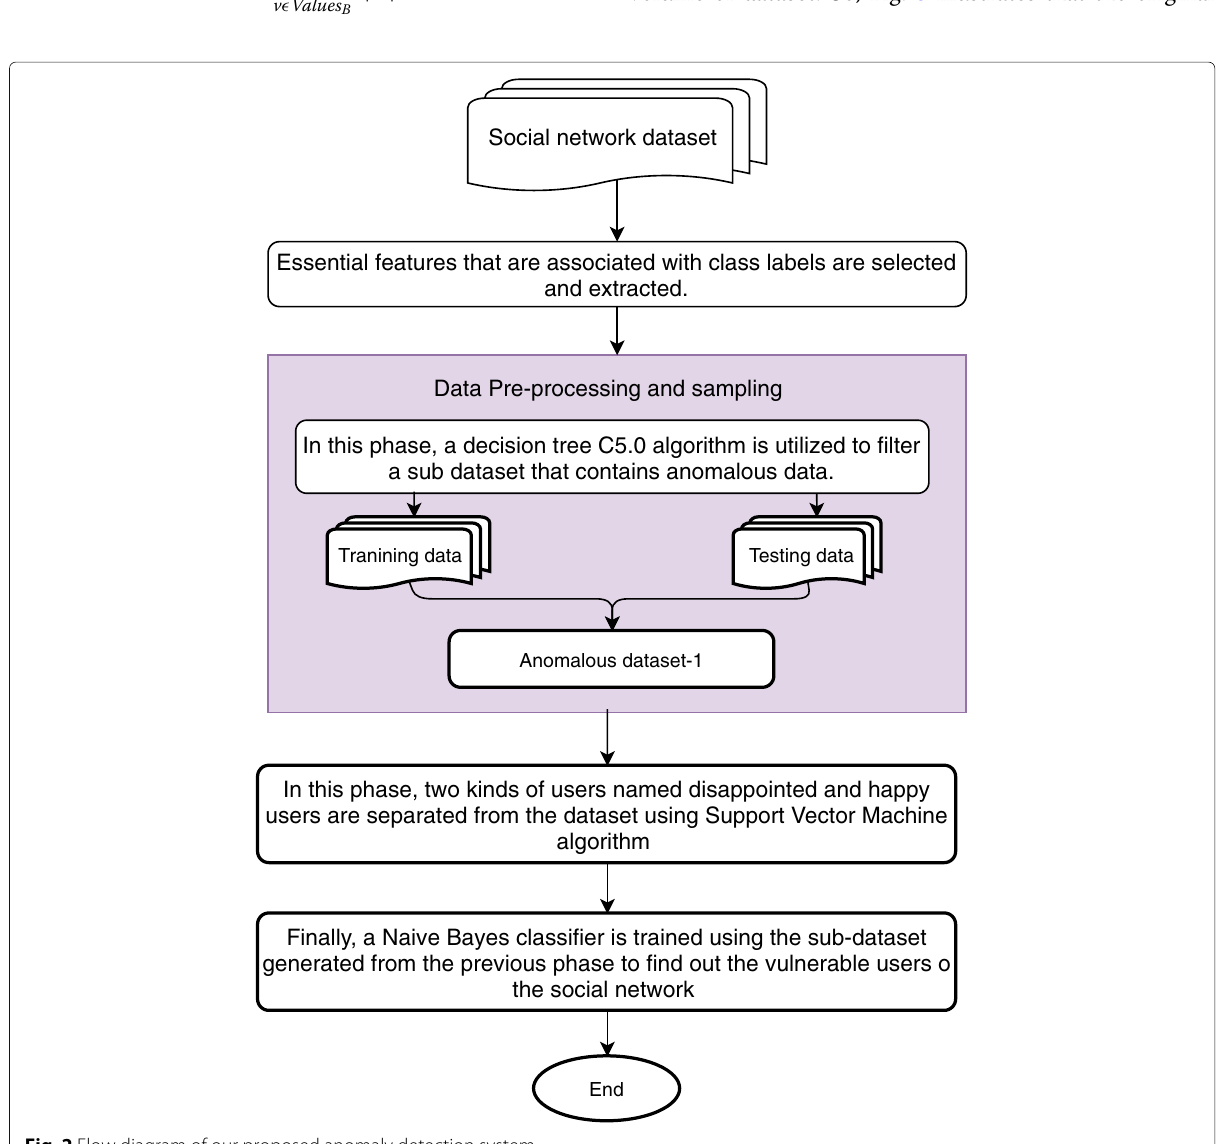
Fig. 2 Flow diagram of our proposed anomaly detection